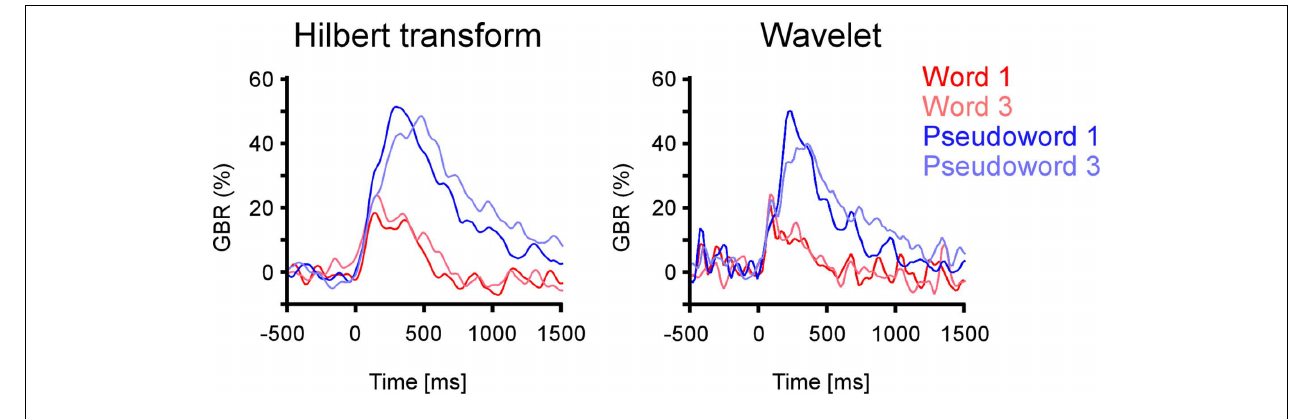
gamma power response estimated with Morlet wavelets.The electrode is located in inferior temporal cortex from patient 1 (Talairach coordinates [ − 53 − 36 − 13]).